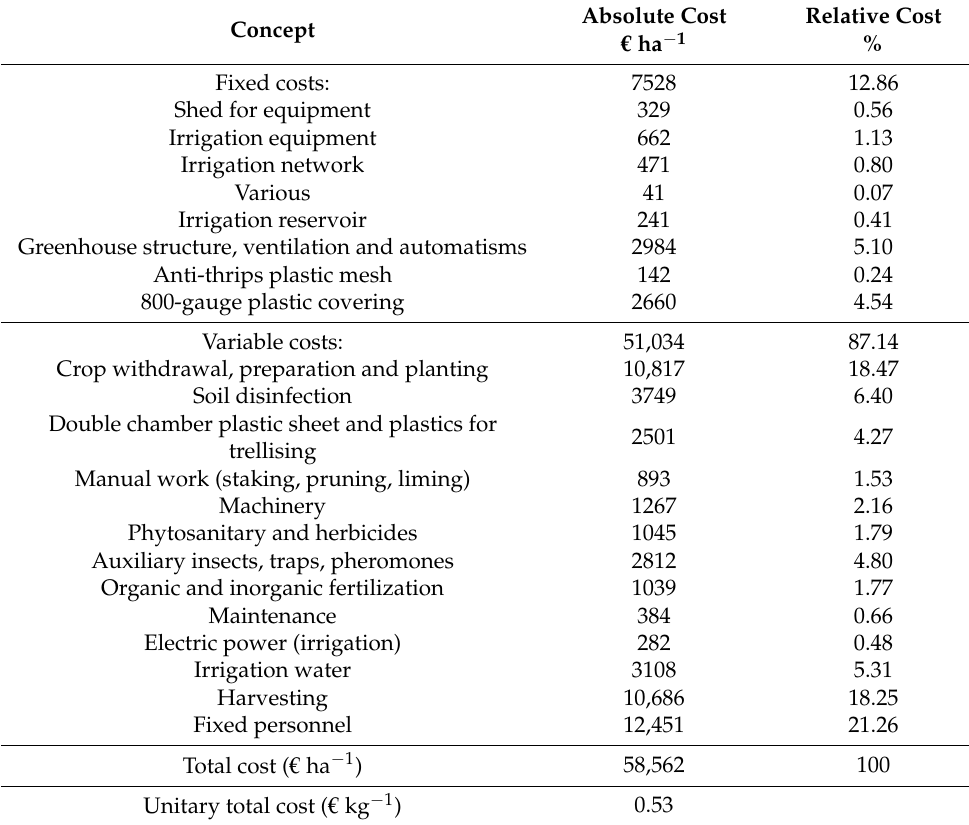
Table 4. Cost structure of greenhouse pepper